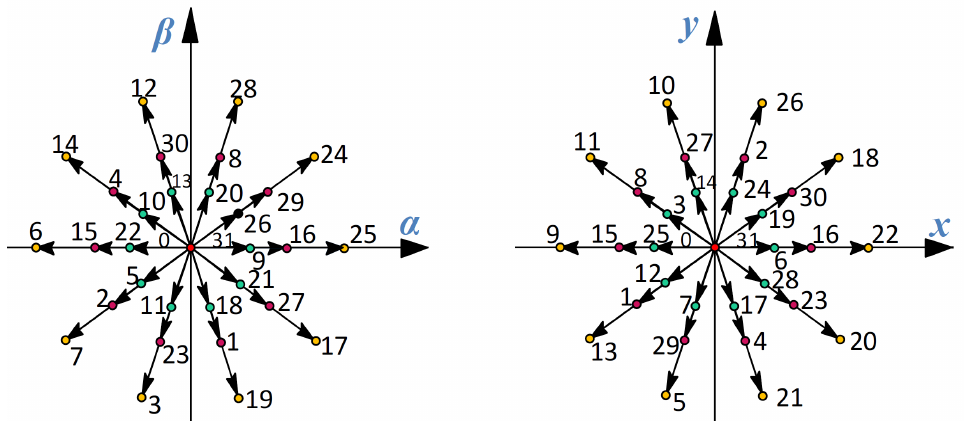
Figure 2. Six-phase voltage constellation in α − β and x − y planes.